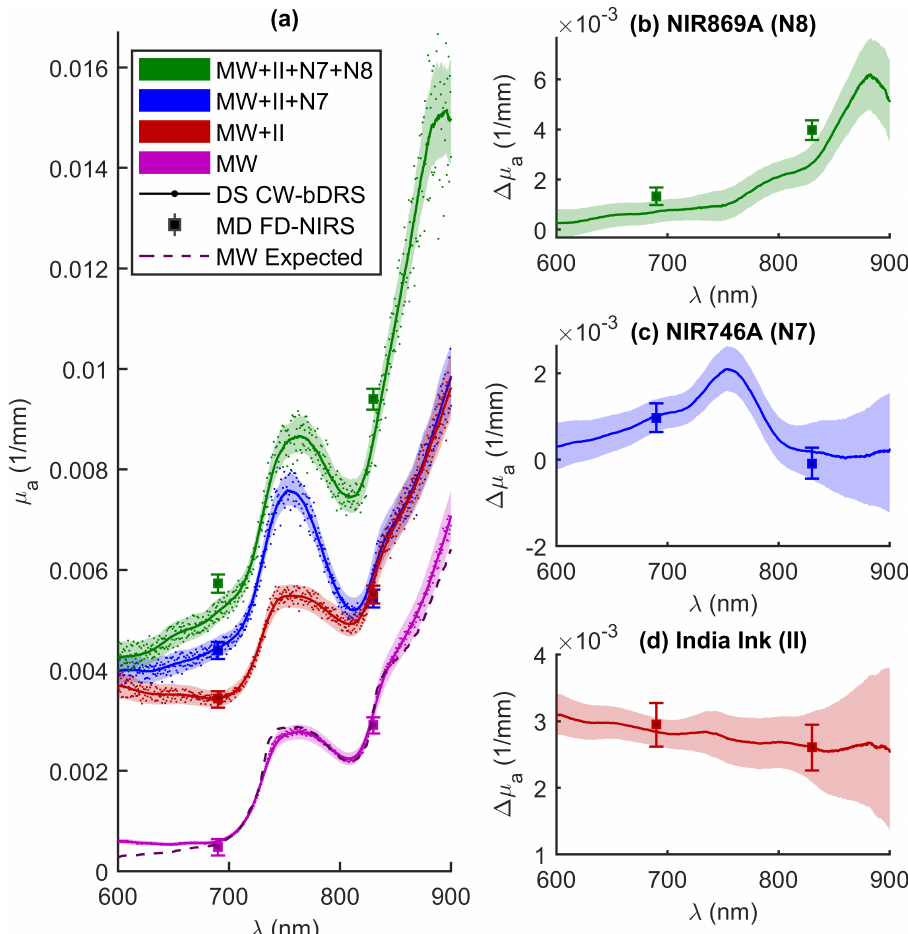
Figure 4. Results from phantom experiment. ( a ) Absolute absorption ( µ a ) spectra as a function of wavelength ( λ ). Showing results from Dual-Slope Continuous-Wave broadband Diffuse Re- flectance Spectroscopy (DS CW-bDRS) and Multi-Distance Frequency-Domain Near-Infrared Spec- troscopy (MD FD-NIRS) measurements. Spectra shown for the following phantoms: Milk and Water (MW), MW plus India Ink (II), MW plus II plus NIR746A (N7), and, finally, MW plus II plus N7 plus NIR869A (N8). DS CW-bDRS points show individual wavelength measurements and lines show smoothed (moving average) spectra for visualization. Dashed line shows the expected spec- trum for MW modeled as water and lipid. ( b ) Change in absorption ( ∆ µ a ) from adding N8 (i.e., µ MW + II + N 7 + N 8 a − µ MW + II + N 7 a ), ( c ) ∆ µ a from adding N7 (i.e., µ MW + N 7 a − µ MW + II a ), and ( d ) ∆ µ a from adding II (i.e., µ MW + II a − µ MW a